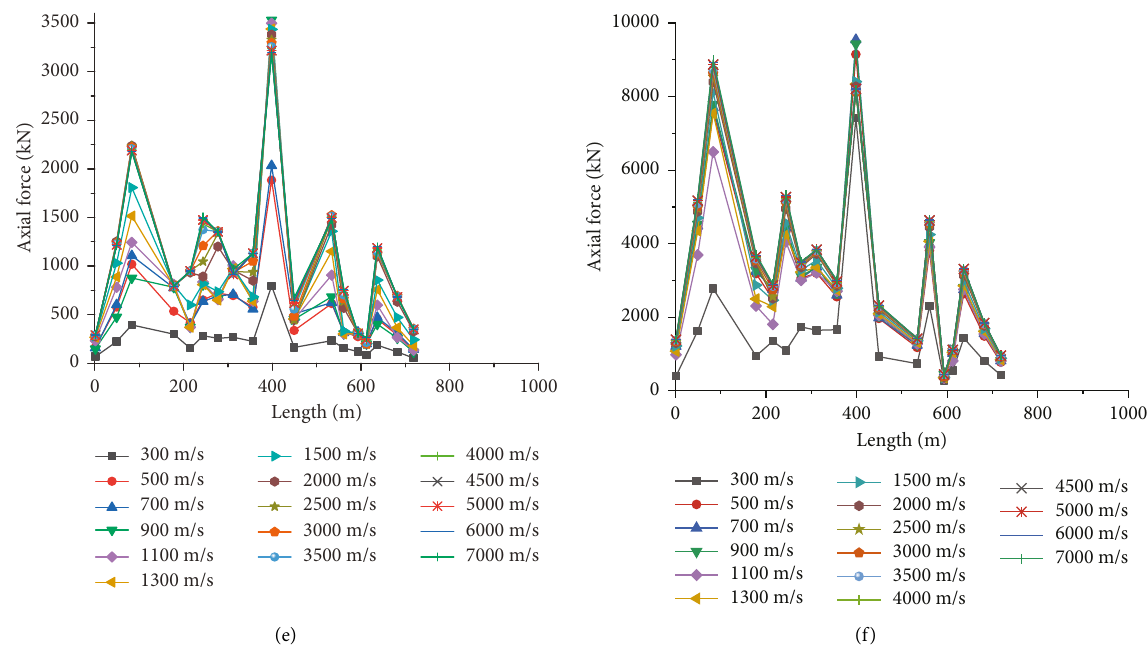
Figure 13: Distribution of maximum displacement and maximum axial force with the length of steel truss main girder under three kinds of seismic waves with different apparent wave velocities. (a) 1979 James RD E1 Centro 220 Deg seismic wave, (b) 1994 Northridge Sylmar County Hosp 90 Deg seismic wave, (c) artificial wave, (d) 1979 James RD E1 Centro 220 Deg seismic wave, (e) 1994 Northridge Sylmar County Hosp 90 Deg seismic wave, and (f) artificial